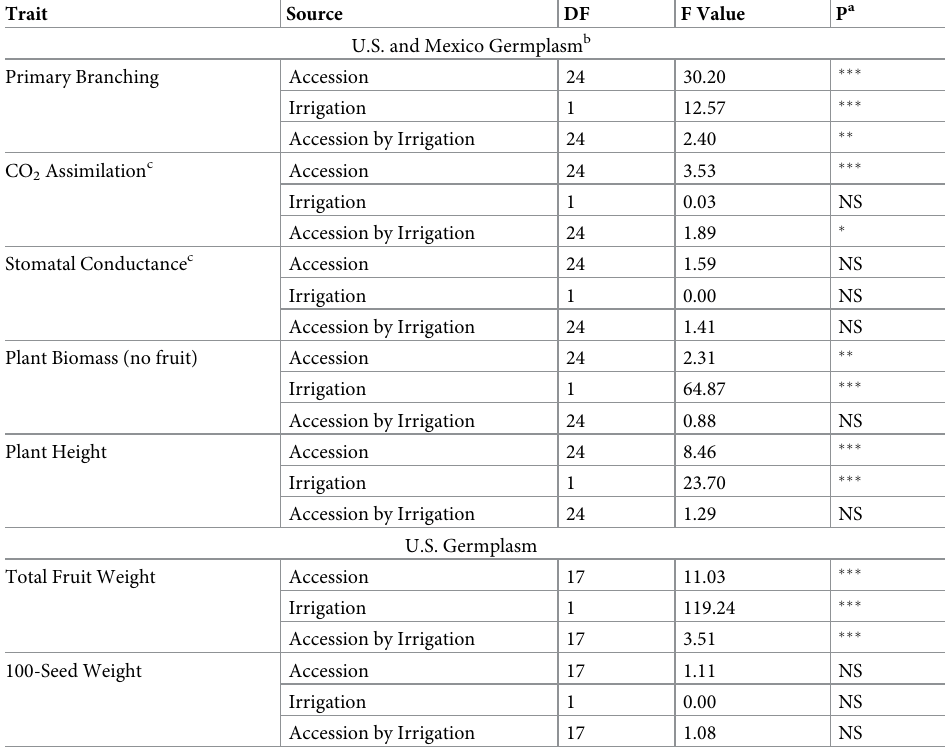
a � , �� , ��� specify significant differences at P values of 0.05, 0.01, and 0.001 respectively. b Yield traits (total fruit weight and 100-seed weight) were analyzed only in U.S. germplasm because of variable phenology between U.S. and Mexican accessions.